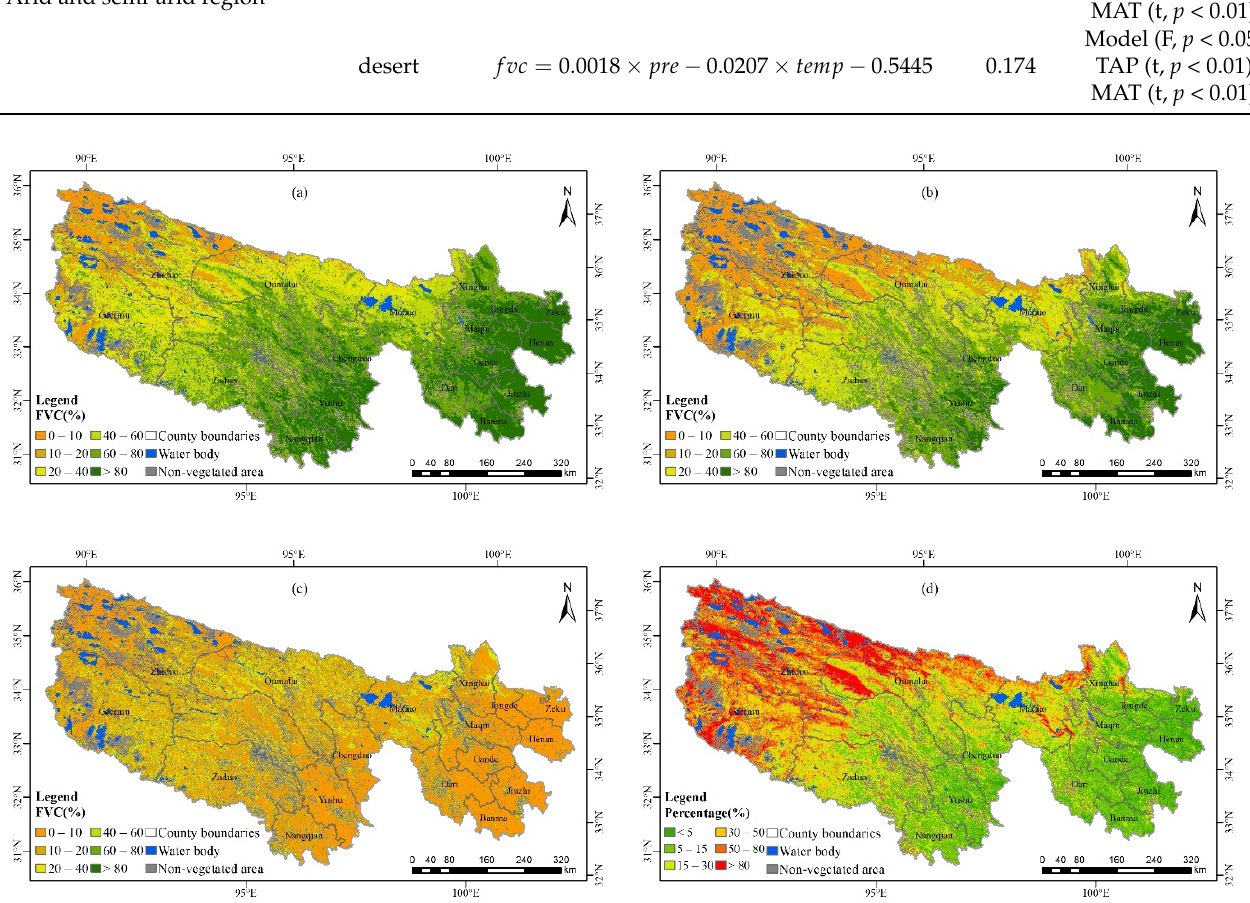
Figure 5. Spatial distribution of average annual FVC ( a ), change trend ( b ), significant trends ( c ) and percentage ( d ) of forest and grass ecosystems in the TRHR from 2000 to 2019.